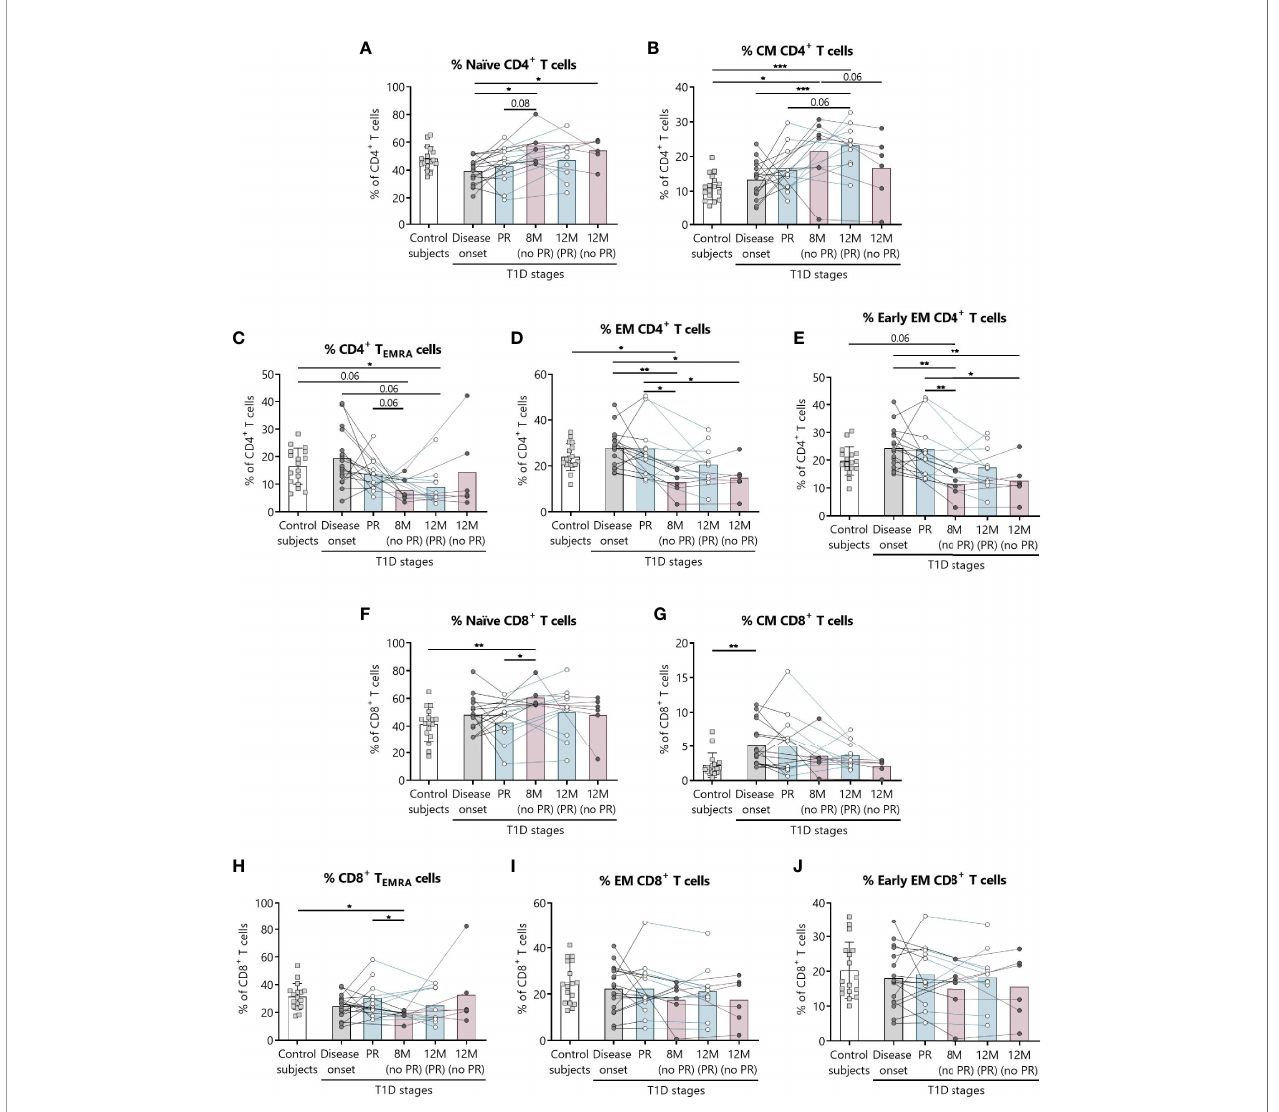
FIGURE 2 | Percentages of CD4 + and CD8 + T lymphocyte subsets are altered at the initial stages of T1D. For CD4 + and CD8 + T lymphocytes, respectively, the percentages (%) of (A, F) naïve T lymphocytes, (B, G) CM T lymphocytes, (C, H) T EMRA lymphocytes, (D, I) EM T lymphocytes, and (E, J) early EM T lymphocytes were determined in peripheral blood of control subjects and patients with T1D at different time-points. Squares represent controls ( n = 17) (white bar), and patients are represented by light gray dots at disease onset ( n = 17) (gray bar), white dots during PR ( n = 11) and for remitter patients at 12 months (12 M PR) ( n = 10) (blue bars), and dark gray dots for non-remitter patients at 8 months (8 M no PR) ( n = 6) and 12 months (12 M no PR) ( n = 6) (pink bars). Bar graphs show mean percentage values. Each symbol represents an individual patient. Lines link the same patient throughout the time-points. * P ≤ 0.05, ** P < 0.01, *** P < 0.001 after mixed effects model with Tukey ’ s post-hoc test for longitudinal data, Kruskal – Wallis with Dunn ’ s post-hoc test for comparisons between control subjects and the different T1D time-points, or 2-tailed Mann – Whitney test for comparisons between two unpaired groups of data. P ≤ 0.05 is considered signi fi